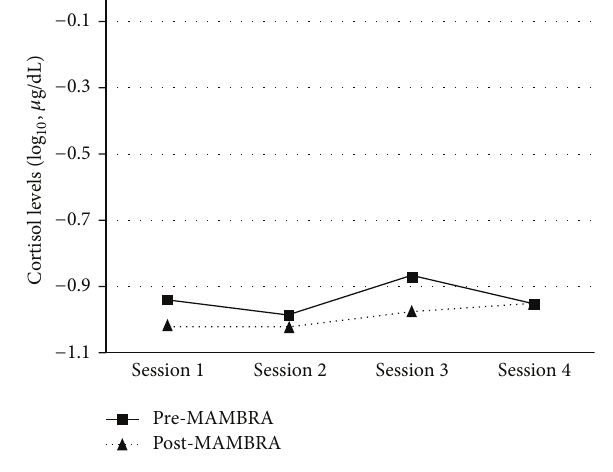
Figure 1: The pre-/post-MAMBRA cortisol levels across the 4